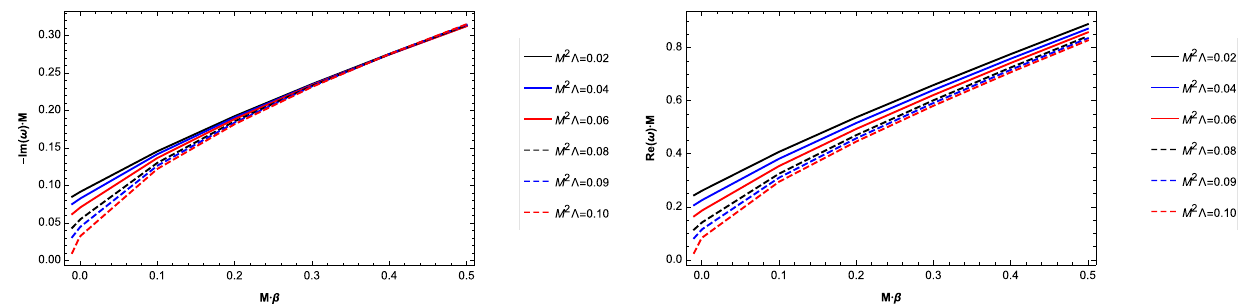
Fig. 3 The behavior of Im (ω) M (left panel) and Re (ω) M (right panel) for the fundamental QNF as a function of M β for massless scalar field with (cid:5) = 1 and different values of the cosmological